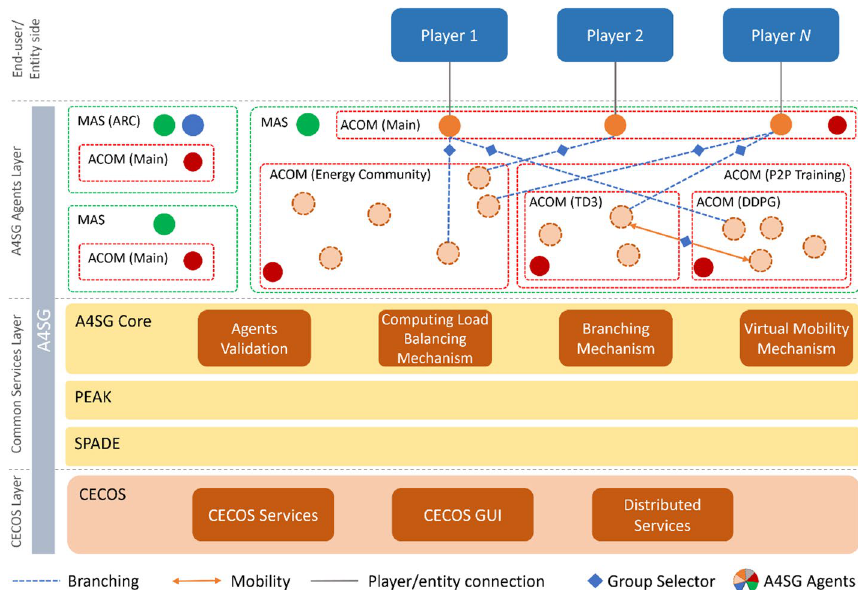
Fig. 2 A4SG architecture to integrate the proposed